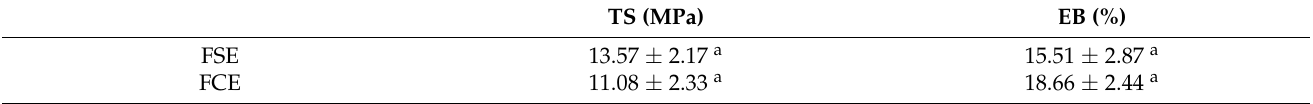
Table 4. Tensile strength (TS) and elongation at break (EB) of films with FCE and without FSE extract.